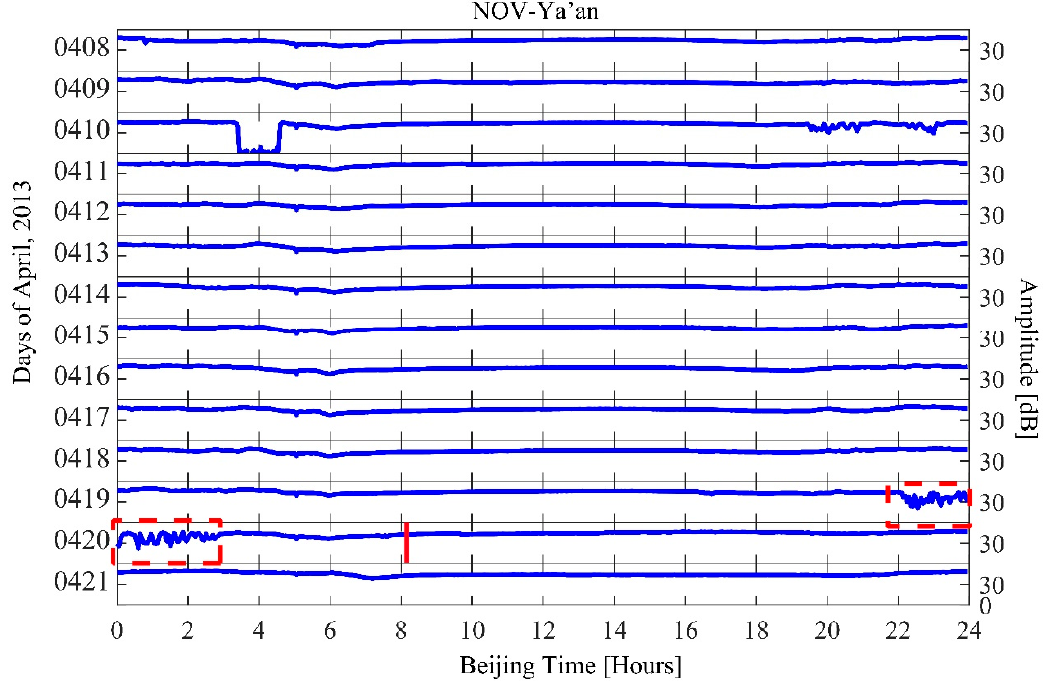
Figure 6. The continuous amplitude of Ez (vertical component of electric field) observed during 8 April–21 April; the red rectangular box denotes the night time fluctuation and the red vertical bar represents the time of the Lushan earthquake.